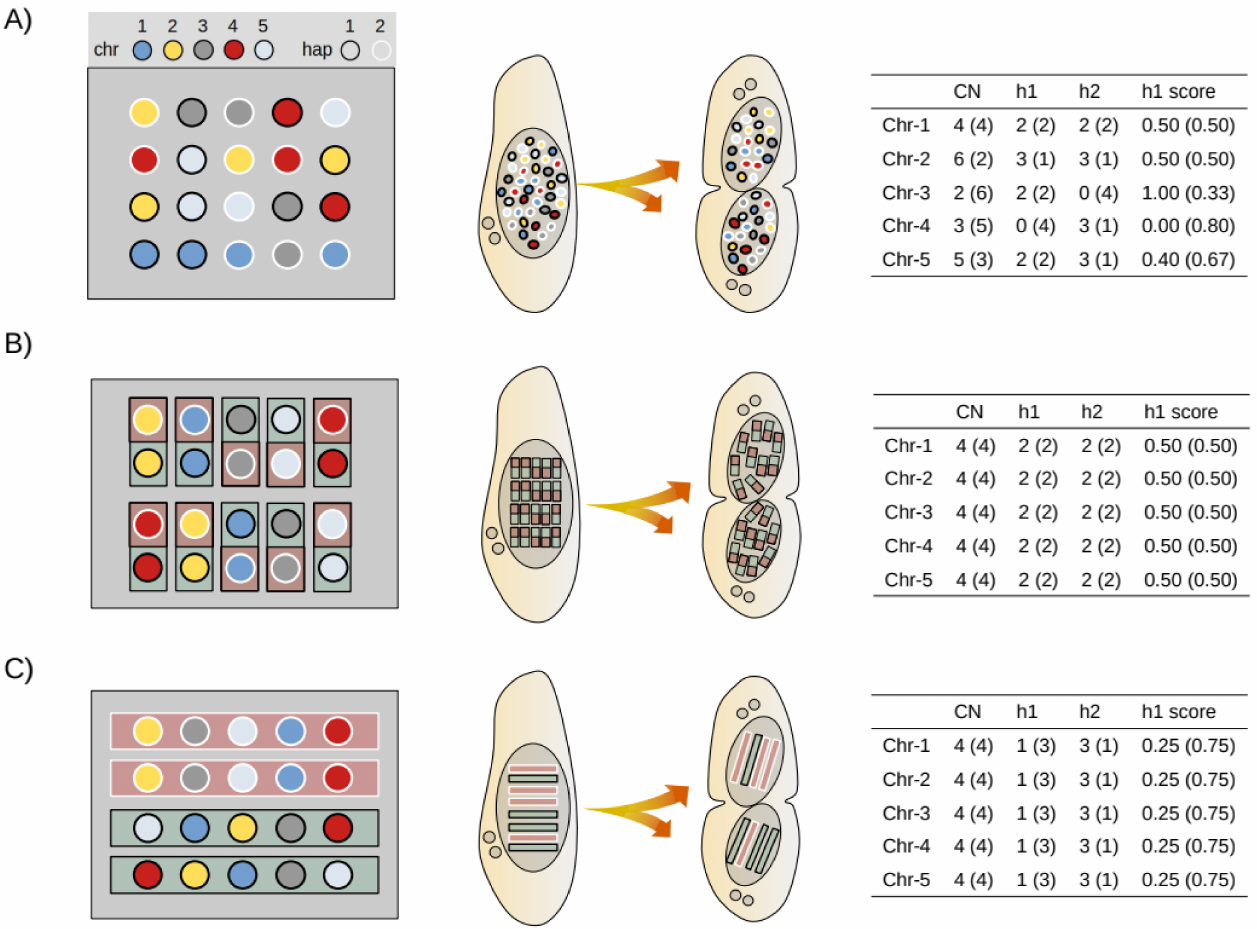
Figure 4. Models of macronuclear architecture in ciliates. Models for a hypothetical tetraploid cell with five somatic chromosome types ( Chr ) generated by conjugation (ex-conjugant). Left. Configuration of macronuclear sub-units in G1 (prior to DNA replication). Center. Random segregation of sub-units during amitotic division. Right. Copy number variation of individual chromosomes and their haplotypes after a single cell division. ( A ) Chromosomal model. Individual somatic chromosomes segregate freely. N = 2 × Chr × k , where N is the total number of segregating sub-units at cell division and k is the ploidy level.; ( B ) Diploid model. Homologous chromosomes are bundled up into diploid sub-units. N = Chr × k ; ( C ) Haploid model. Full sets of chromosomes are bundled into single haploid sub-units. Each sub-unit contains a full complement of chromosomal variants from either one of the parental haplotypes (but not both). N = 2 × k . CN , Copy Number. h1 , CN of haplotype 1. h2 , CN of haplotype 2. h1 score , nuclear prevalence of haplotype 1. h1 = h1 /( h1 + h2 ). Before cell division, CN = k and h1 = h2 = 0.50 for each chromosome type. Each daughter cell receives exactly half of the sub-units ( N /2) at cell division (number of sub-units in G1). All chromosomes are depicted as heterozygous for illustration purposes